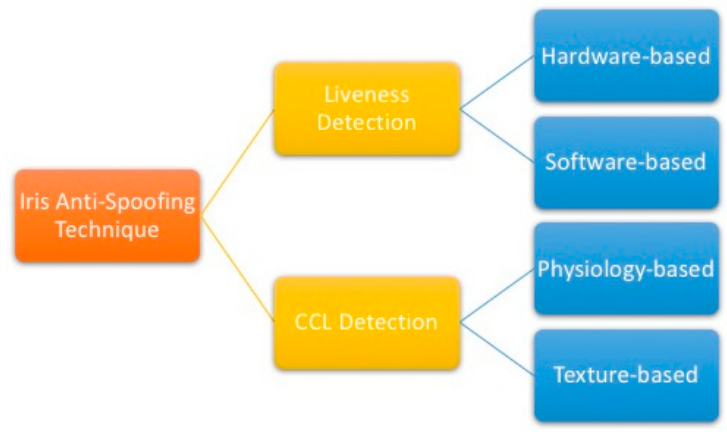
Figure 2. Summary of the division of the iris anti-spoofing technique.